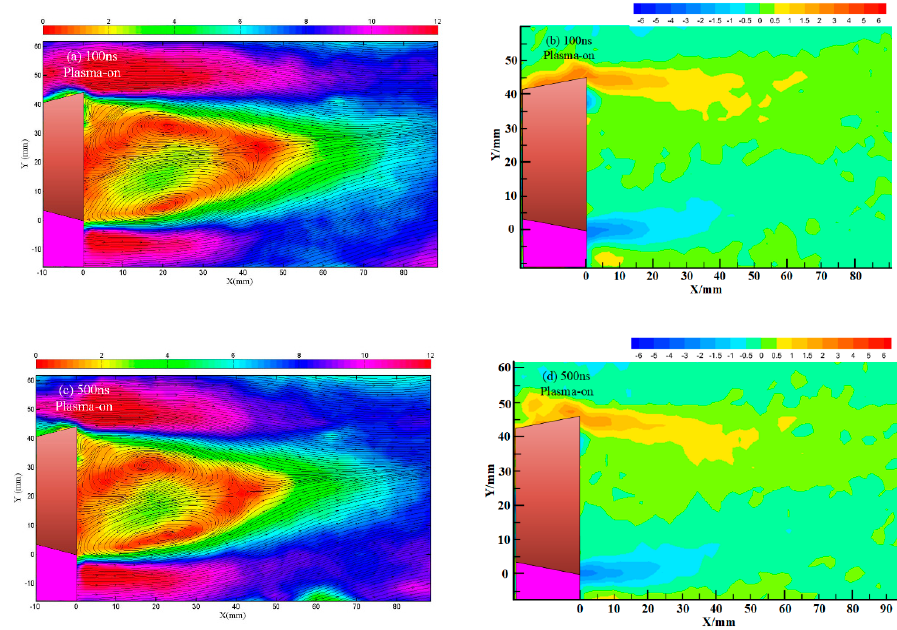
Figure 23. T ime − averaged flow structures ( left ) and vorticity contours ( right ) of the flame − holder Figure 23. Time-averaged flow structures ( left ) and vorticity contours ( right ) of the flame-holder wake with different rising − edge times, ( a , b ) 100 ns rising − edge, ( c , d ) 500 ns rising − edge. wake with different rising-edge times, ( a , b ) 100 ns rising-edge, ( c , d ) 500 ns